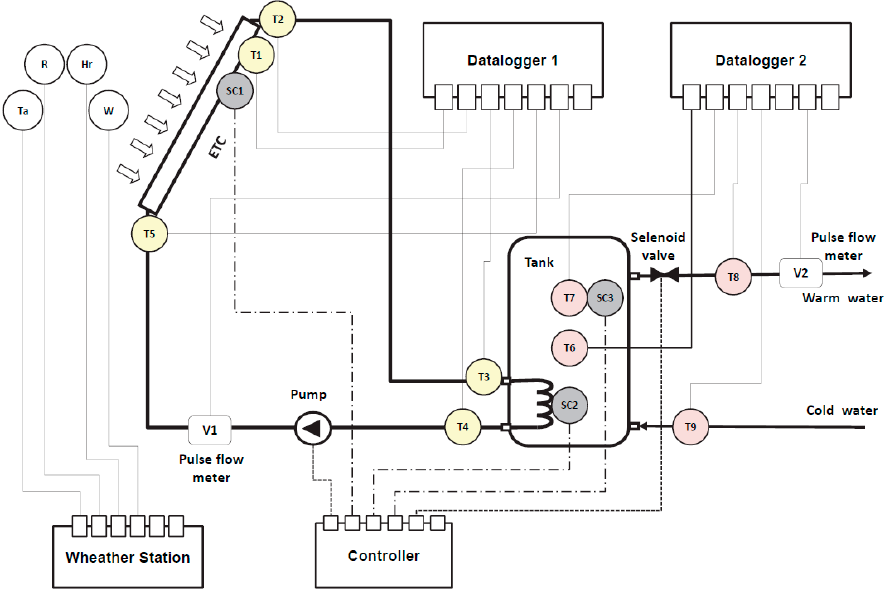
Figure 1. Main components of the active solar water heating (SWH) system. ETC: evacuated tube collector.